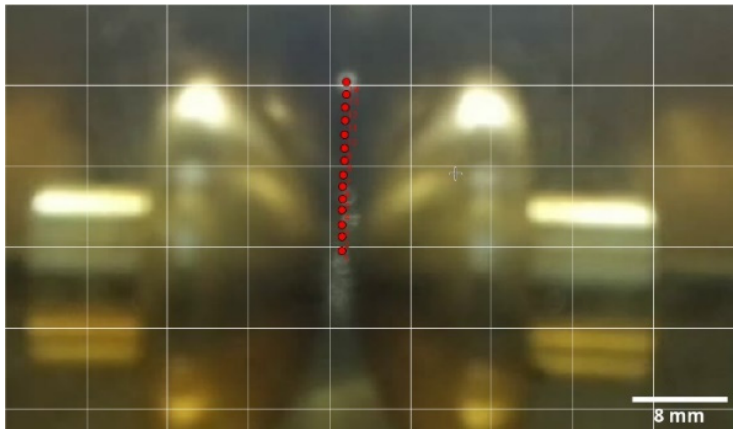
Figure 22. Position of the bubble at 14 instants of time for the experiment in Table 8. Table 8. Determination of the kinematic viscosity of the oil using gas